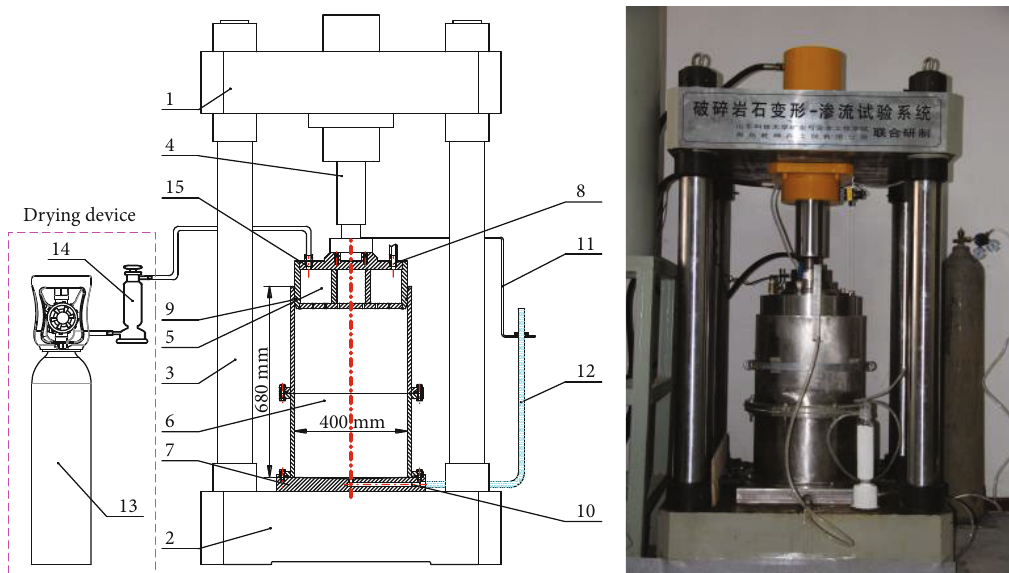
Figure 1: Deformation-seepage experimental system for crushed gangues [38]. 1: beam of the test system; 2: bedplate of the test system; 3: column; 4: load cylinder; 5: loading pressure head; 6: test cylinder; 7: bedplate of the test cylinder; 8: intake; 9: seal ring; 10: outlet; 11: fi xing trestle; 12: blowout; 13: nitrogen cylinder; 14: drying tower; 15: air inlet.